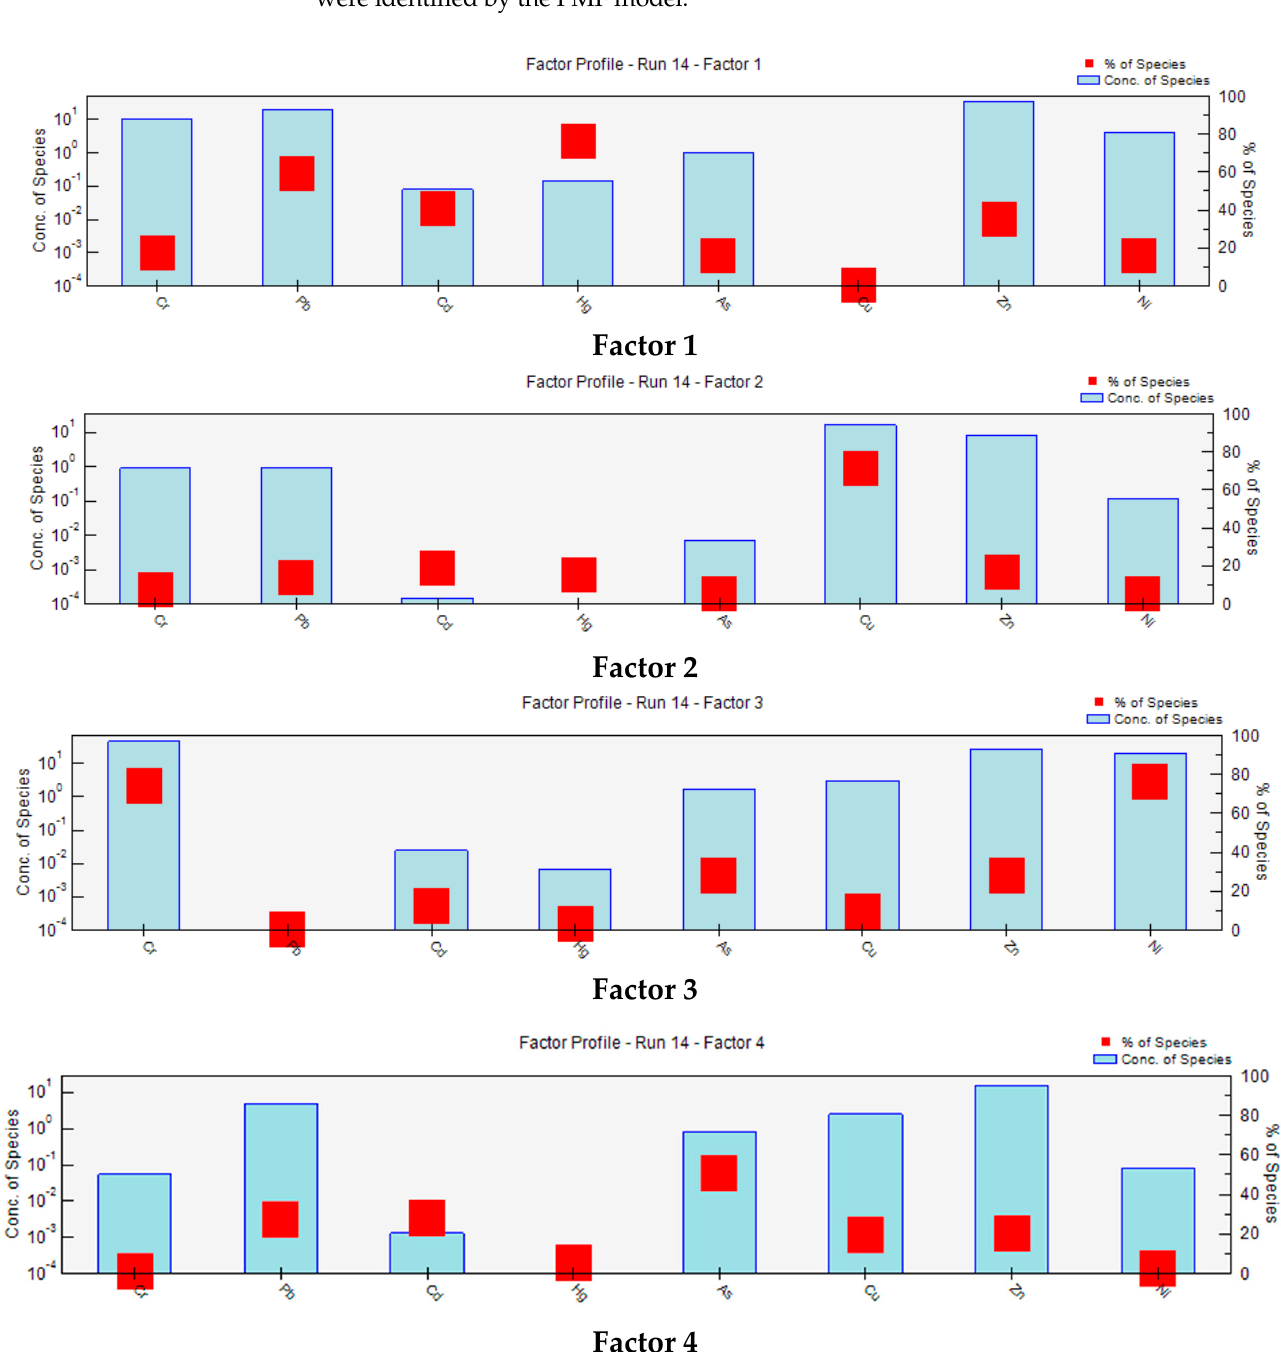
Figure 8. Contributions of different sources to TEs outputted by PMF model.